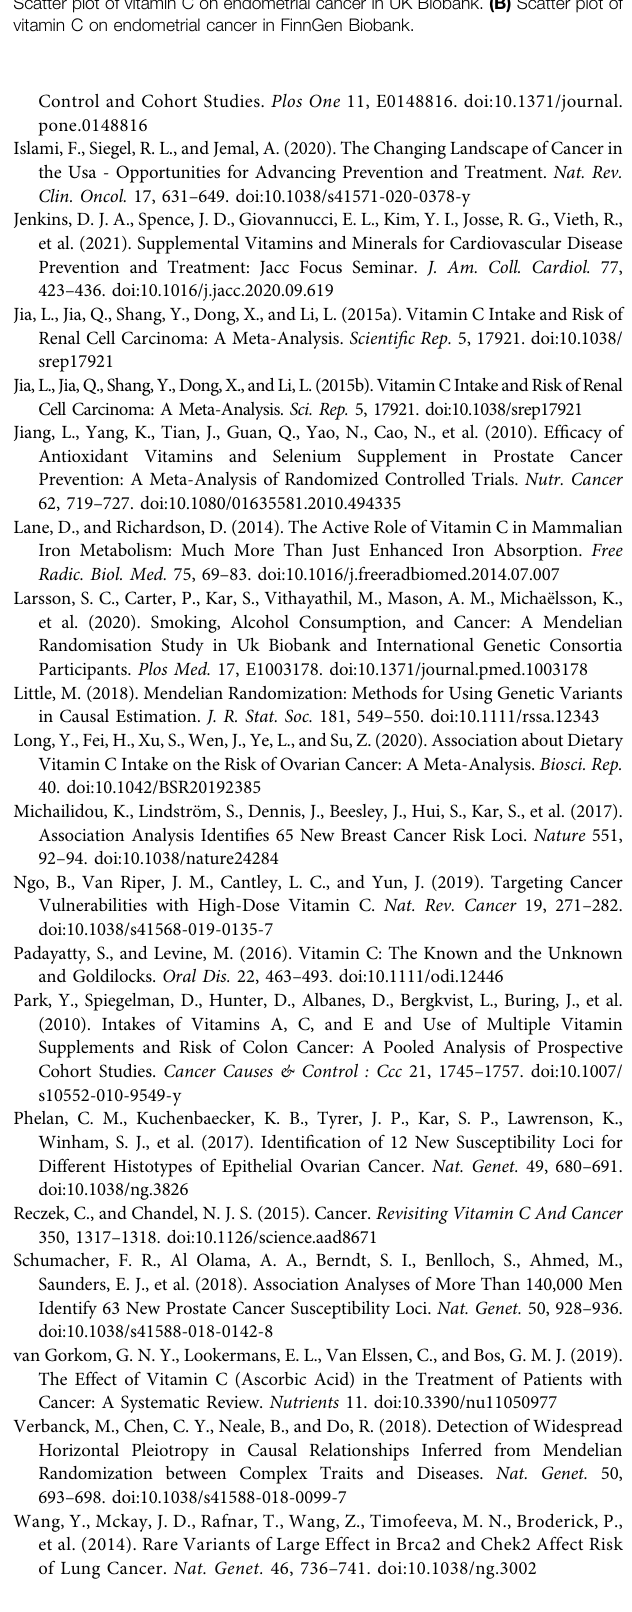
vitamin C on ovarian cancer in FinnGen Biobank. (C) Scatter plot of vitamin C on ovarian cancer in OCAC. OCAC, Ovarian Cancer Association Consortium.